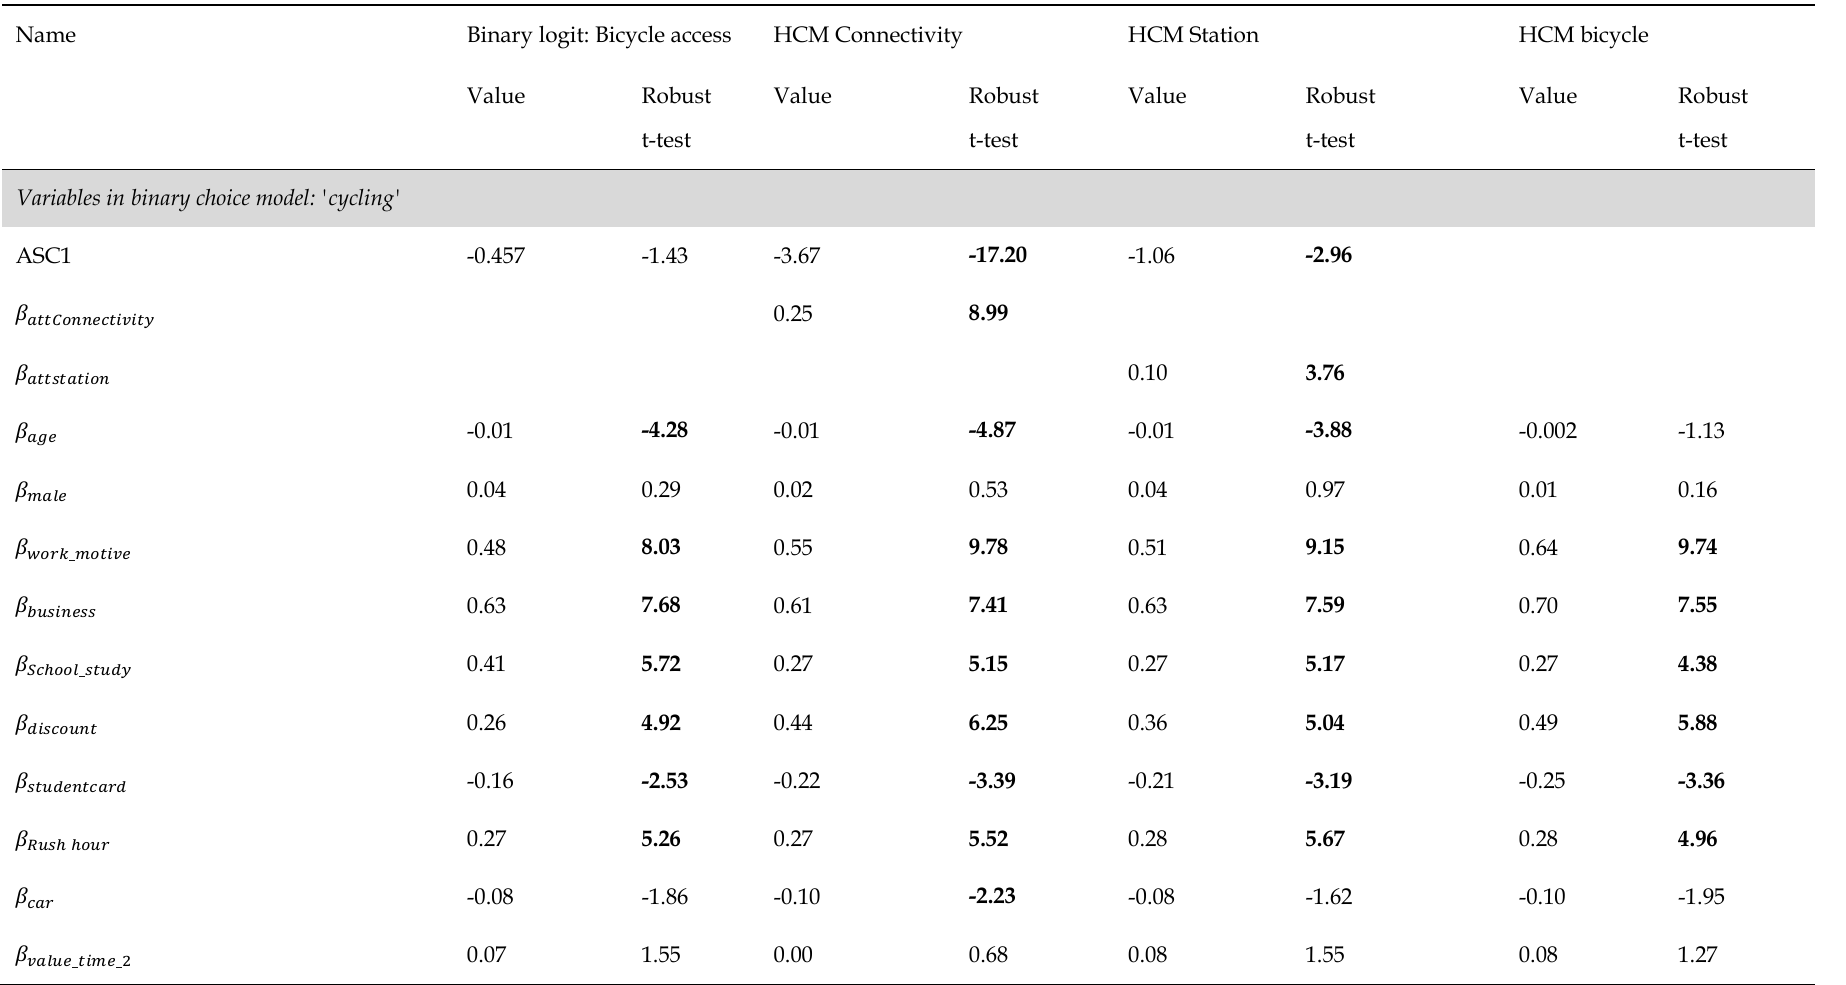
Table 3. Discrete choice and latent variables in the hybrid